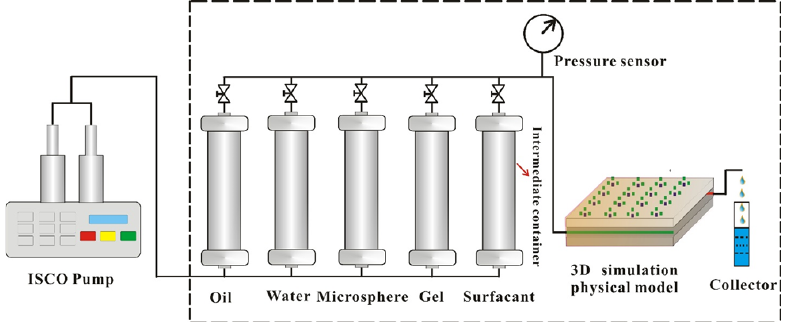
Figure 2. Experimental process diagram.